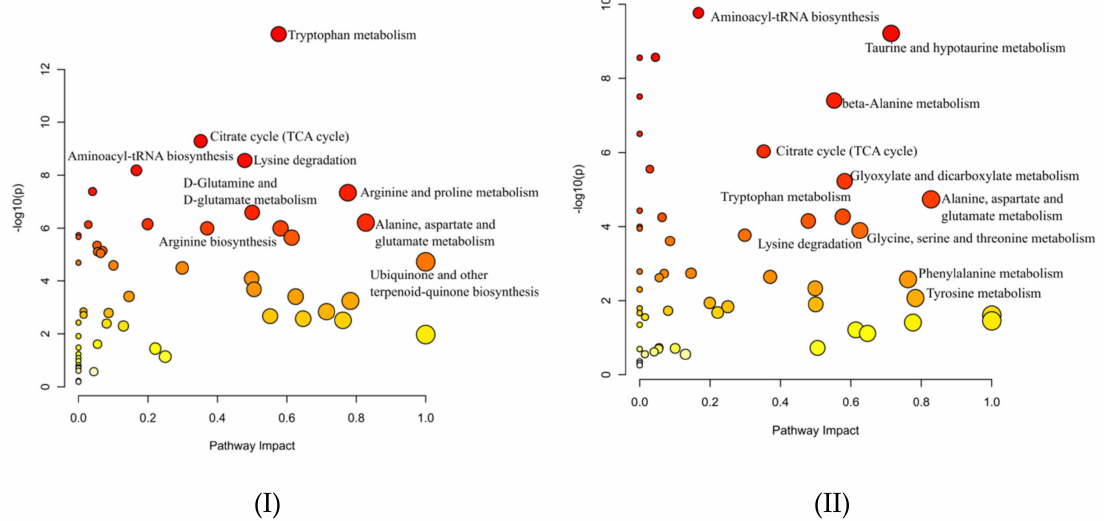
Figure 5. Comparison of main pathways present in the cereal